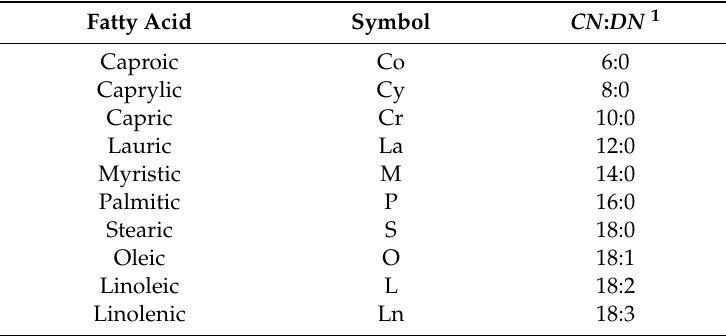
Table 2. Abbreviations for different types of fatty acids.